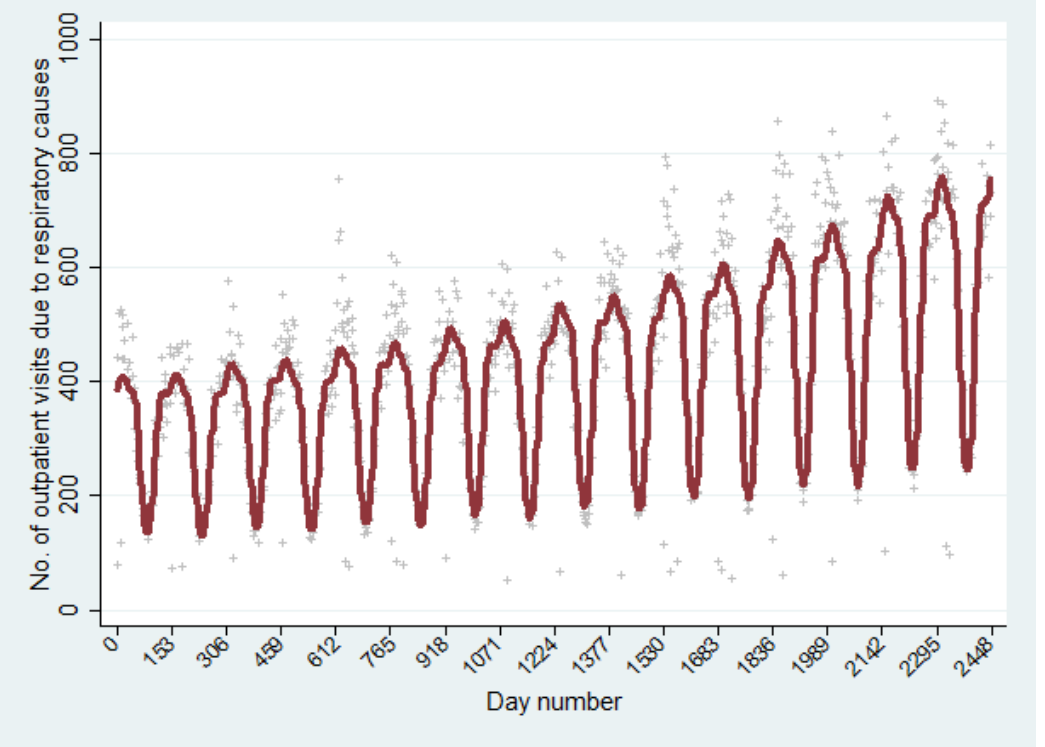
Figure 1. GLM model showing the number of outpatient visits due respiratory causes over time. The days of the total observation period (153 days per year, ranging between 1 May and 31 September annually from 2002 to 2017) are coded as days 1–2448, regardless of the year. The adjustment for time trends was performed by using sinus and cosinus terms with wavelengths at 3, 4, 6, 12, and 24 months, as well as a linear term (the day number) and a quadratic term (the day number